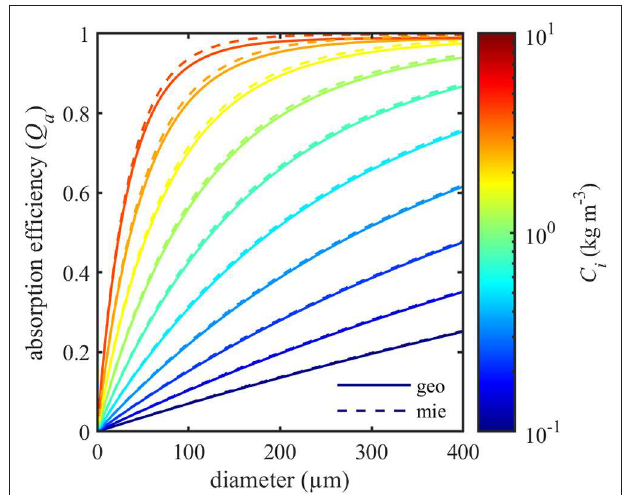
FIGURE 3 | Comparison of absorption efficiencies ( Q a ) at 676 nm calculated with geometric optics (geo, solid lines) and Lorenz-Mie theory (mie, dashed lines) for spheres of various size and intracellular chlorophyll content ( C i